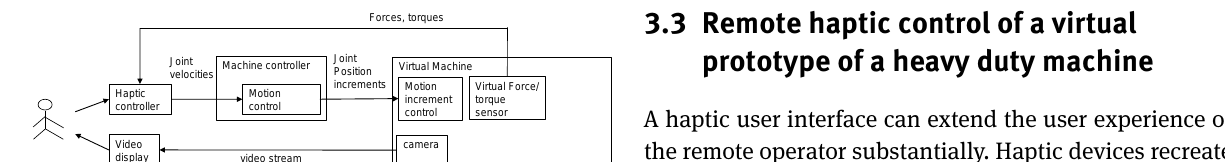
tunneled over TCP/IP and the 5G PoC radio to the CAN bus of the real machine control system (see Figure